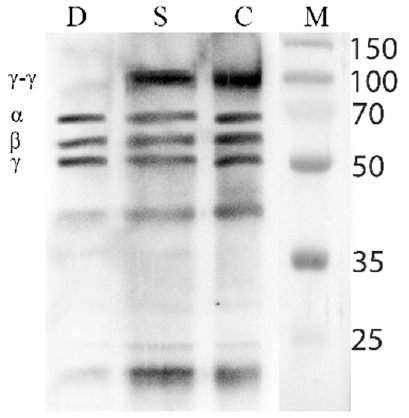
Figure 5. Fibrinolytic activity of destabilase. The Western blot with polyclonal anti-fibrinogen antibody of blood clot fragments treated with destabilase (D), streptokinase (S), and control buffer (C). M—pre-stained protein ladder (15–150 kDa), α , β , γ — α , β , γ -chains of human fibrin (63.5, 56, and 47 kDa, respectively).